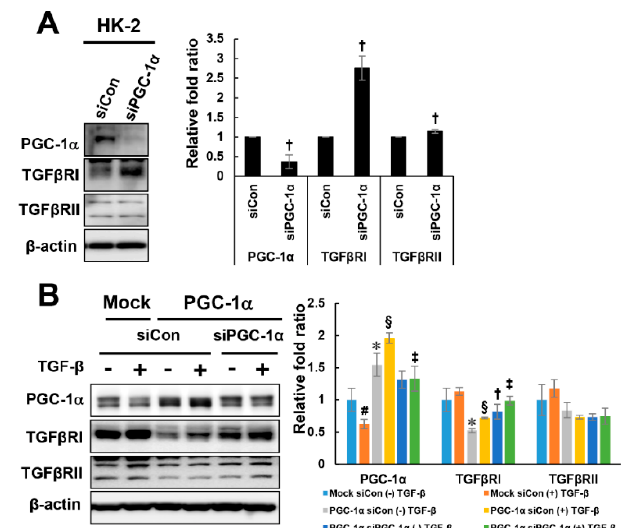
Figure 5. PGC-1 α -specific TGF β RI regulation. To confirm whether TGF β RI modulation is PGC-1 α - specific, PGC-1 α was knocked down using PGC-1 α siRNA (30 nM, Dharmacon) in HK-2 cells ( A ) and mock and PGC-1 α cells ( B ). After 48 h of transfection, the cells were treated with TGF- β for 2 h, harvested and analyzed by western blotting with the indicated antibodies (against PGC-1 α , TGF β RI, and TGF β RII). # p < 0.05, TGF- β -treated vs. untreated mock cells; * p < 0.05, untreated mock cells vs. PGC-1 α cells; § p < 0.05, TGF- β -treated mock cells vs. PGC-1 α cells; † p < 0.05, siCon vs. siPGC-1 α treatment of untreated PGC-1 α cells; ‡ p < 0.05, siCon vs. siPGC-1 α treatment of TGF- β -treated PGC-1 α cells.